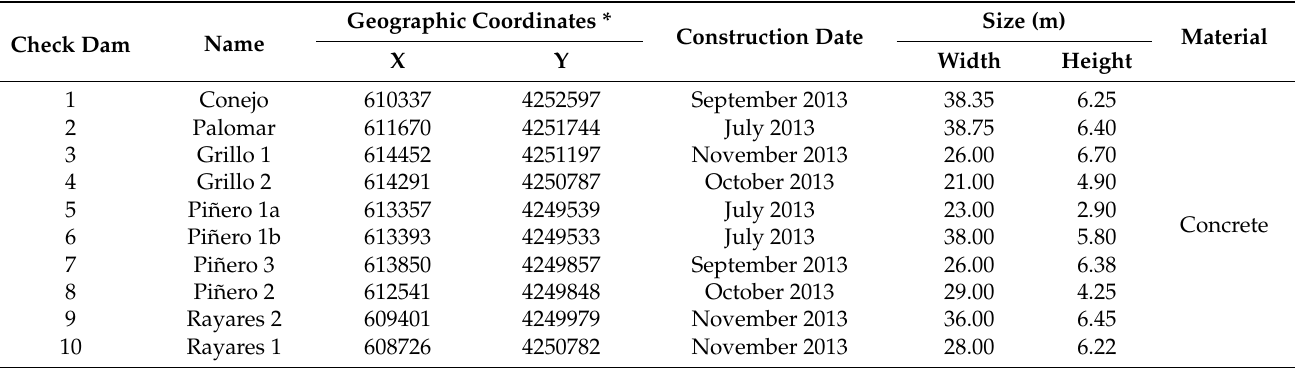
Table 1. Main characteristics of the ten check dams included in the post fire emergency restoration works in Sierra de Los Donceles forest by the government of Castilla-La Mancha Region (Spain).